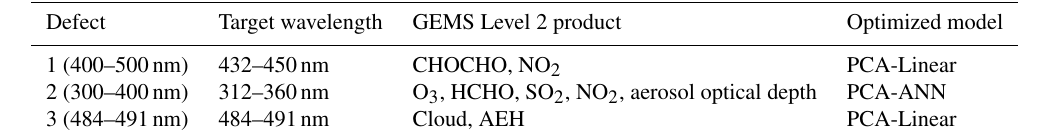
Table 3. The spectral range of Defects 1–3 and target wavelengths for the analysis. The third column presents GEMS retrieval products for which the fitting window is overlapped with Defects 1–3.